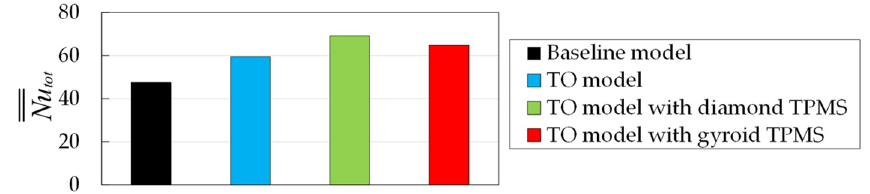
16 of 24 Figure 15. Globally averaged Nusselt numbers for all serpentine channels at Re = 10,000. The total Nusselt number ( tot Nu ) presents the total heat transfer performance based on the flat base heating area. The total Nusselt number includes the heat transfer contri ‐ bution from all wetted surfaces, as the total heat transfer is experienced by the turbine blade’s suction and pressure walls, and it is calculated as follows: w tot (27) where A h is the flat heated area. It is noted that the total wetted area of the TO model, TO model with diamond ‐ and TO model with gyroid ‐ TPMS structures are increased by 8.5%, 15.6% and 13.3% compared to the baseline channel. The total Nusselt number at the Reynolds number of 10,000 is